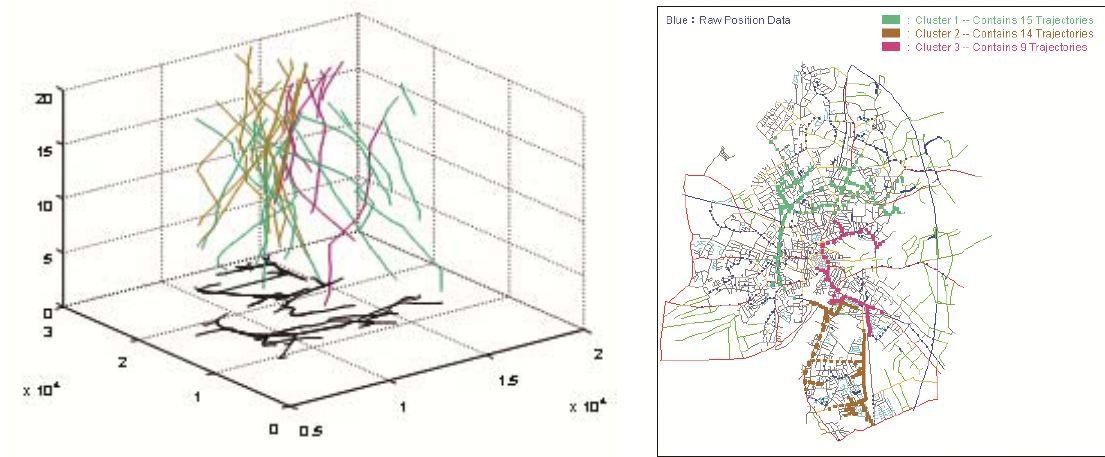
Fig. 8. Trajectory clustering results with proposed spatio-temporal similarity, stops characteristic points are NOT considered during spatio-temporal similarity analysis. (A) is clusters showed in MATLAB, (B) shows clusters in road network map.